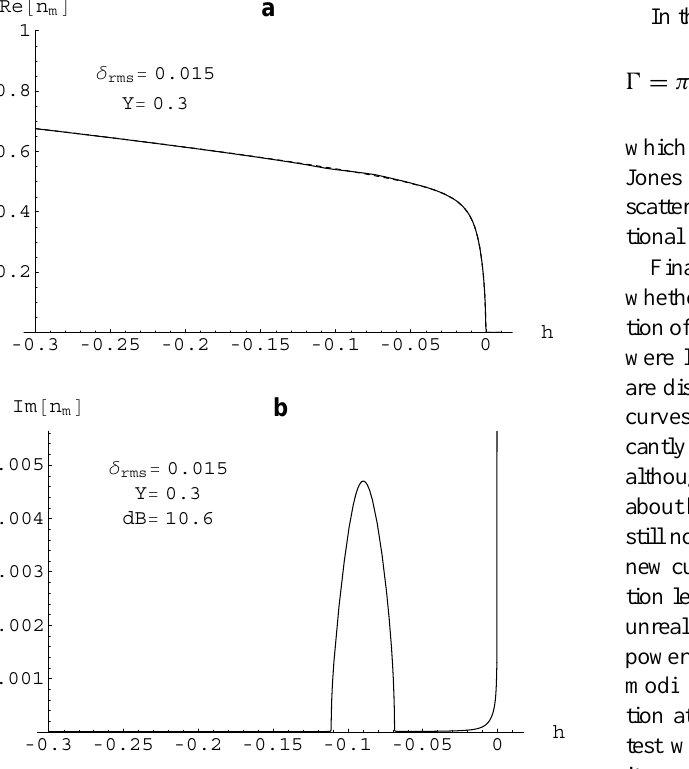
Fig.5 Fig. 5. The real (a) and imaginary (b) parts of the refractive index, n m , of an O-mode test wave, as a function of scaled height coordi- nate, h , for the rms fractional striation amplitude, δ rms = 0 .